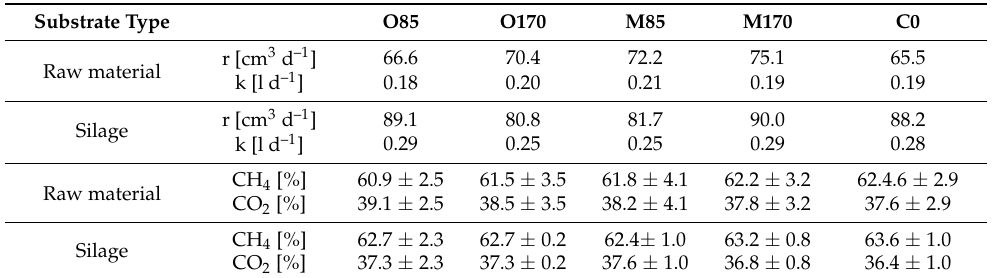
Table 7. Biogas production rate (r), the reaction rate constant (k) and methane (CH 4 ), carbon dioxide (CO 2 ) content in biogas of the analyzed raw material, and silage of Silphium perfoliatum